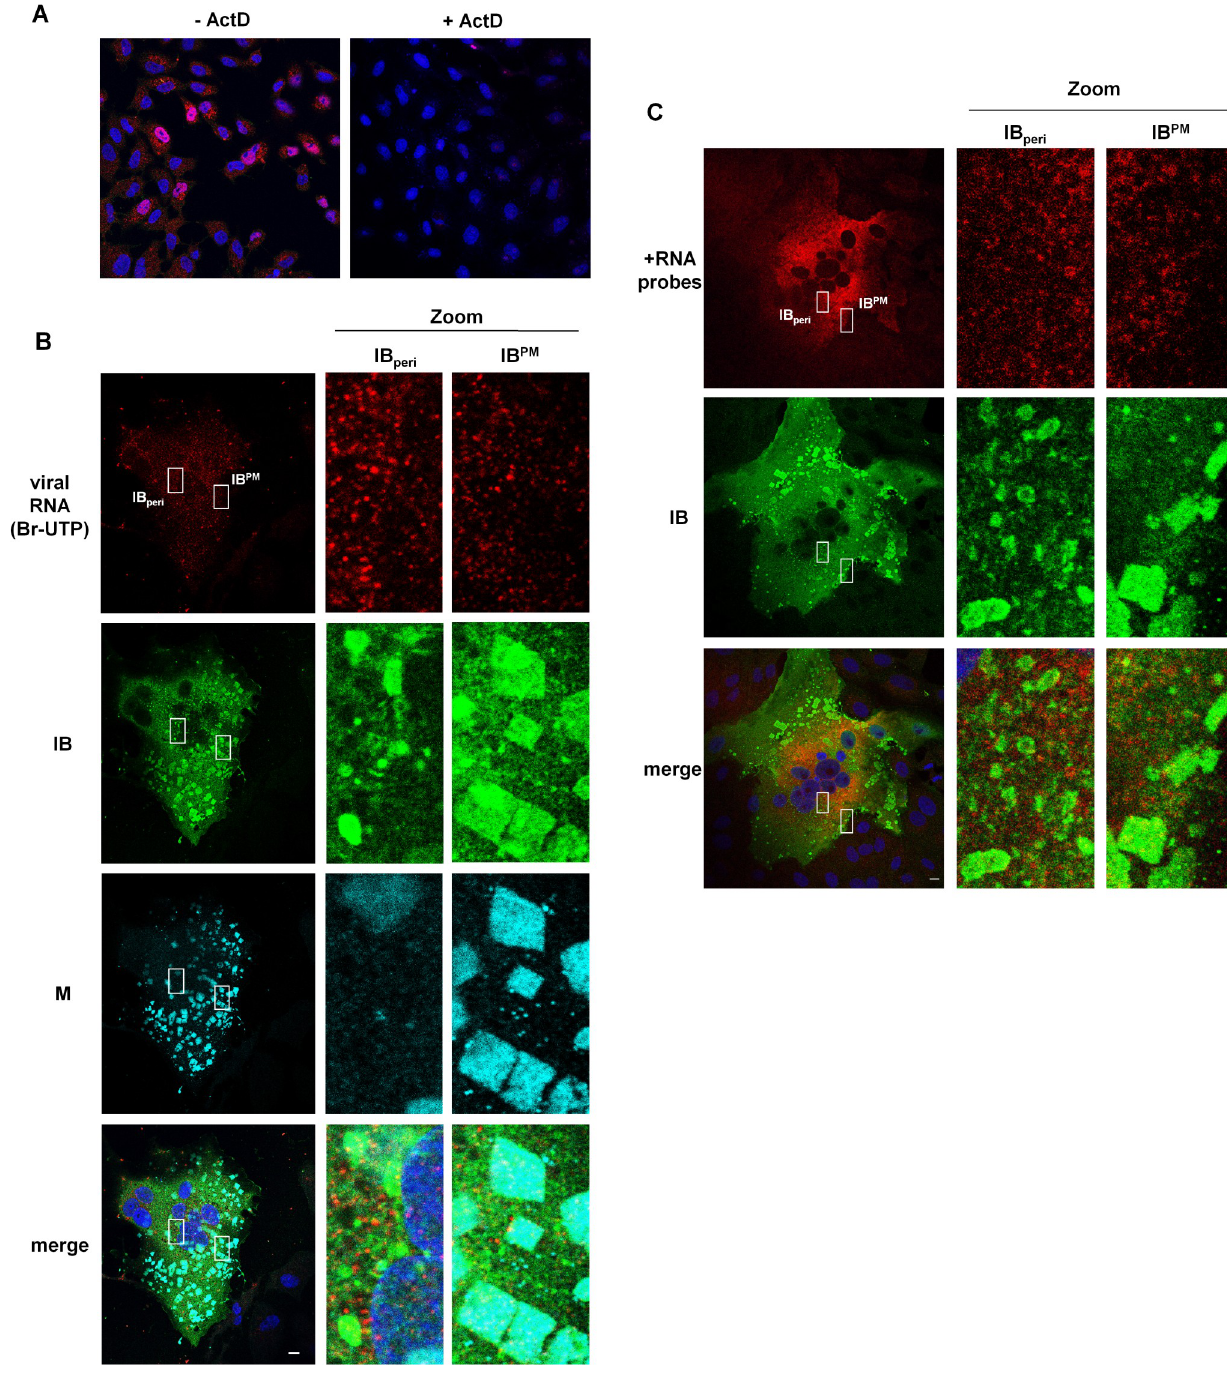
Fig 6. Localization of viral RNA in NiV-infected cells. (A, B) Colocalization of de novo synthesized Br-UTP labeled RNA with IBs. Vero76 cells were infected with NiV at a MOI of 0.05. 18 h p.i. cells were treated for 1 h with actinomycin D to inhibit cellular transcription or left untreated. Then, cells were transfected with 10 mM Br-UTP. After 20 min, cells were fixed and permeabilized with methanol/acetone. Newly synthesized RNAs were detected using a Br-UTP monoclonal antibody (red). (A) Cellular RNA staining in uninfected control cells (Mock) without (-ActD) and with inhibitor (+ActD) are shown. (B) In actinomycin D-treated NiV-infected cells, IBs were visualized with an NiV N-specific antiserum (green) and Zenon-labeled anti-M peptide serum (cyan). (C) Detection of NiV mRNA by FISH. NiV-infected Vero76 cells were fixed at 18 h p.i. and were probed with Quasar 670-labeled FISH probes targeting the positive-sense NiV RNA from nucleotide 1–6000 (+RNA probes). After hybridization to visualize viral N, P and M mRNA (pseudo-colored in red), the N protein was immunostained to detect IBs (green). Nuclei were counterstained with DAPI (blue). In the zoom panels of the confocal images, enlarged views of IB peri and IB PM are shown. Scale bars, 10 μ